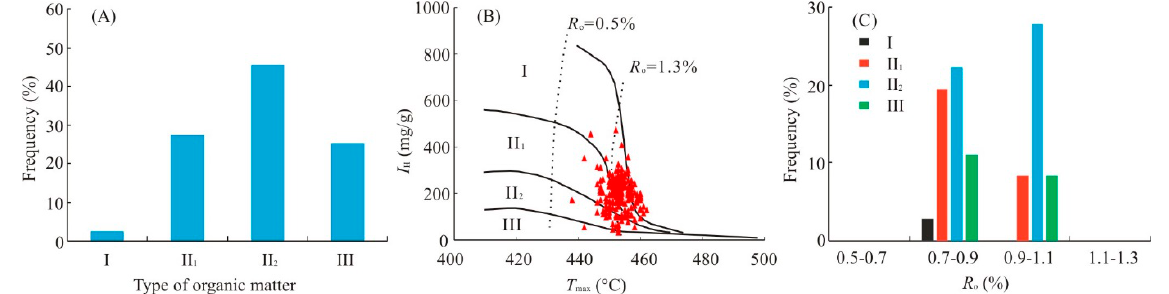
Figure 3. The type and maturity of OM in K 1 yc 4 in the South Shuangcheng Fault Depression: ( A ) kerogen maceral analyses; ( B ) I H – T max intersection diagram; ( C ) vitrinite reflectance.